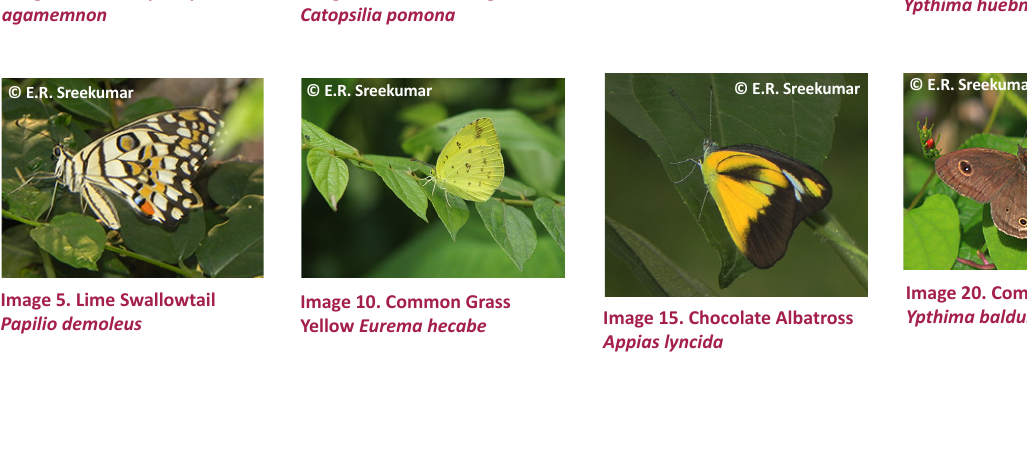
Image 14. Psyche Leptosia nina